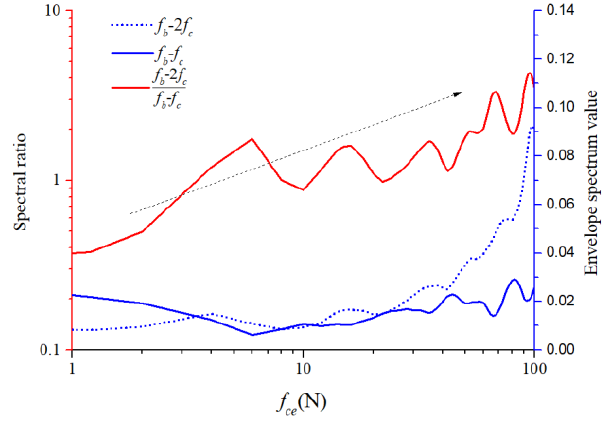
Figure 33. Modulation of lower sideband graph.